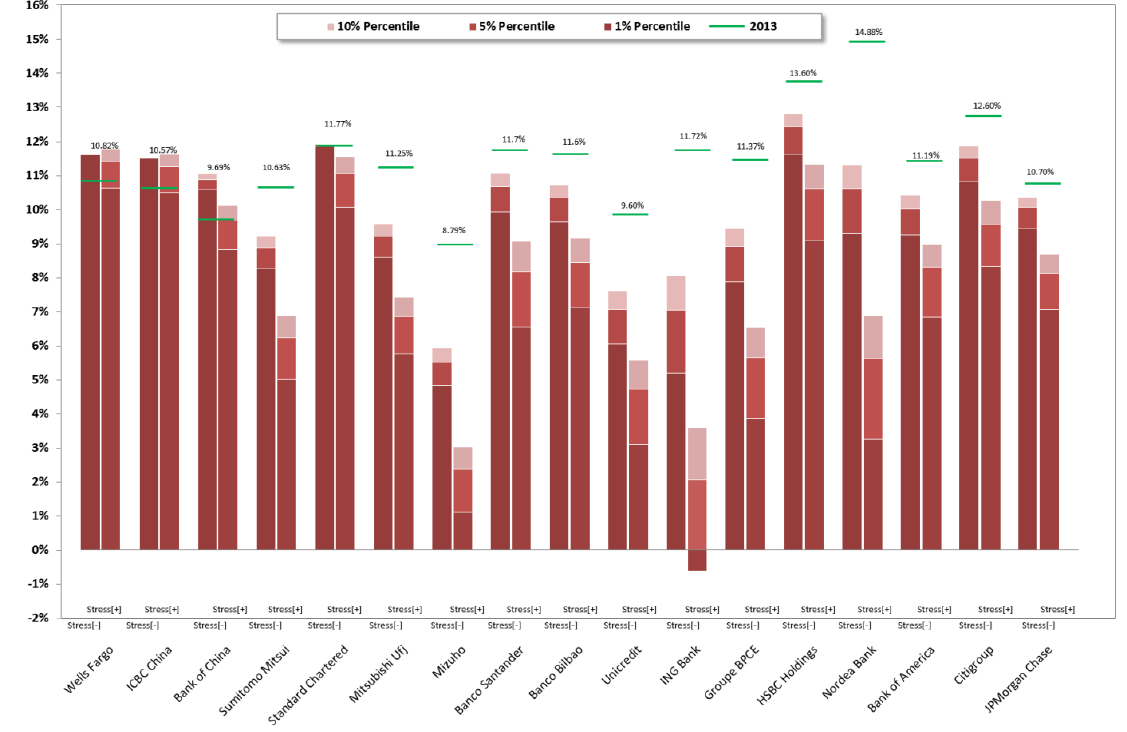
Figure 2. Stressed CET1 ratio 2015 vs. CET1 ratio 2013. CB & CBU.